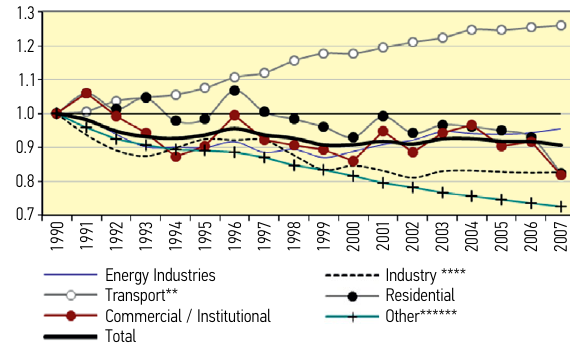
Fig. 1. GHG emissions in the EU-27, by sector (1990 =